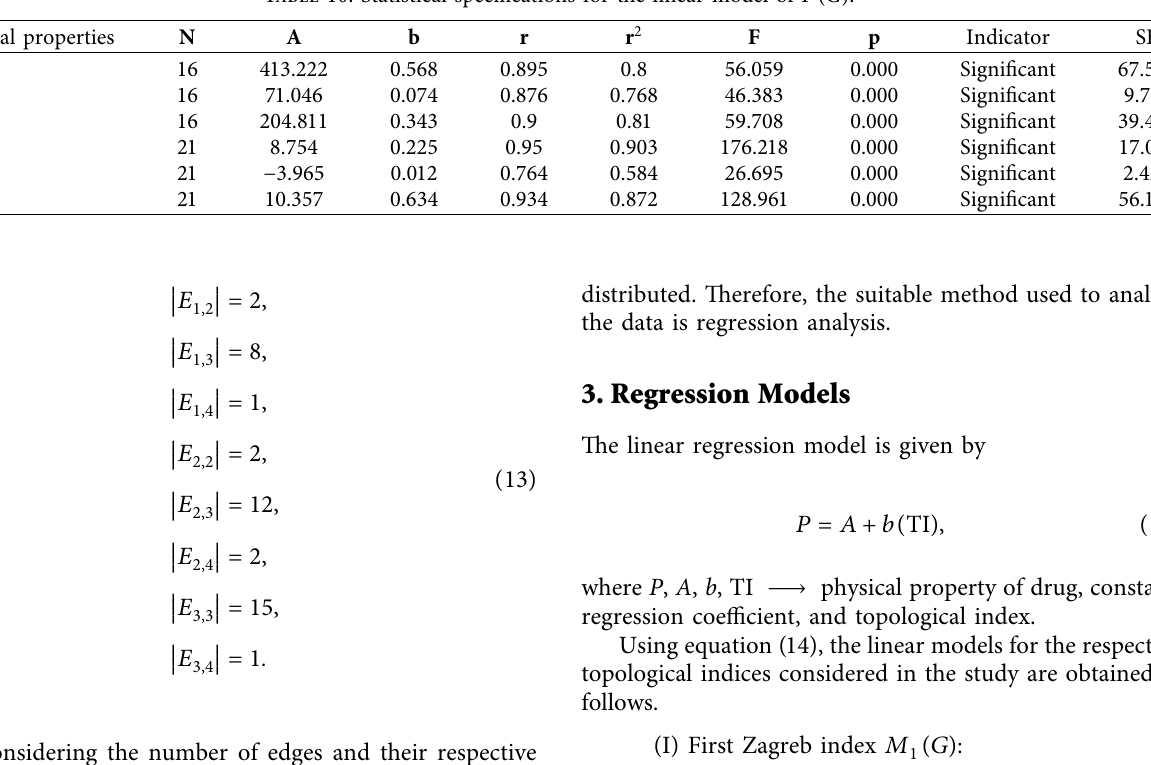
Table 10: Statistical specifications for the linear model of F ( G ) .